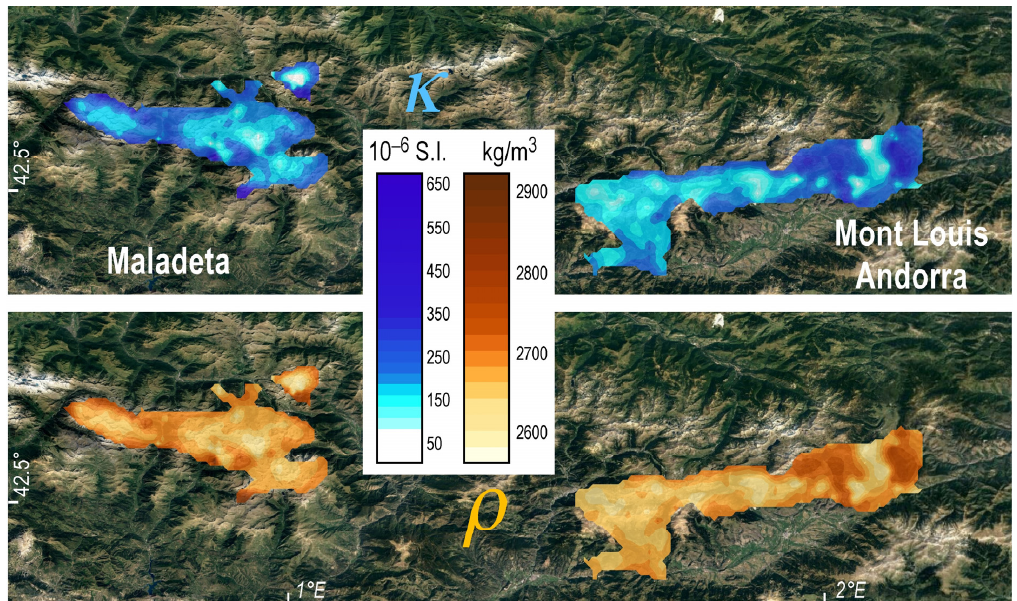
Figure 11. Magnetic susceptibility ( κ ) and density ( ρ ) mapping in the central Pyrenees. From west to east: Maladeta, Marimanha and Mont Louis-Andorra plutons.